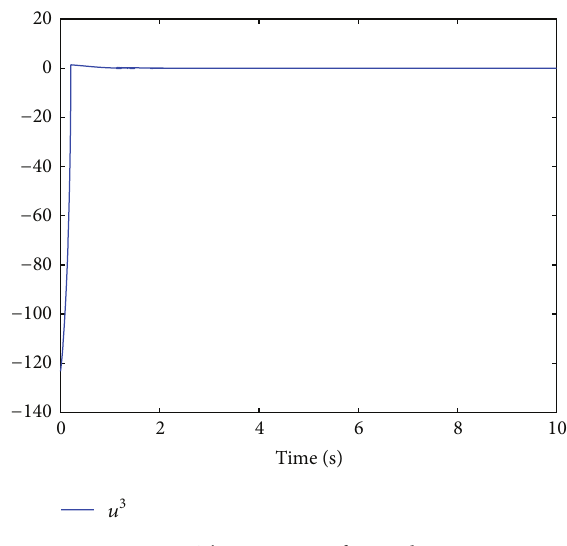
Figure 2: The trajectory of control